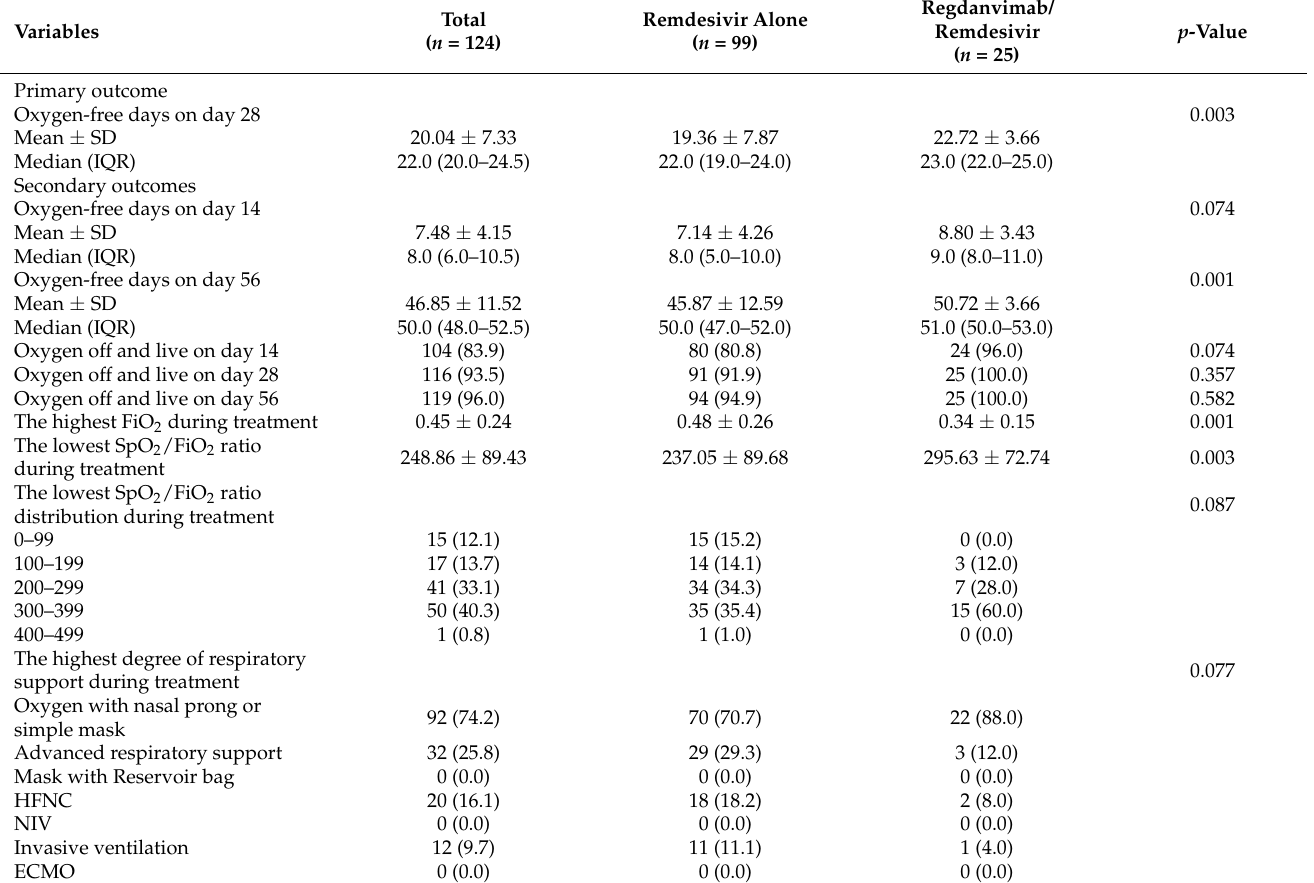
Table 2. Clinical outcomes of the remdesivir alone group and the regdanvimab/remdesivir